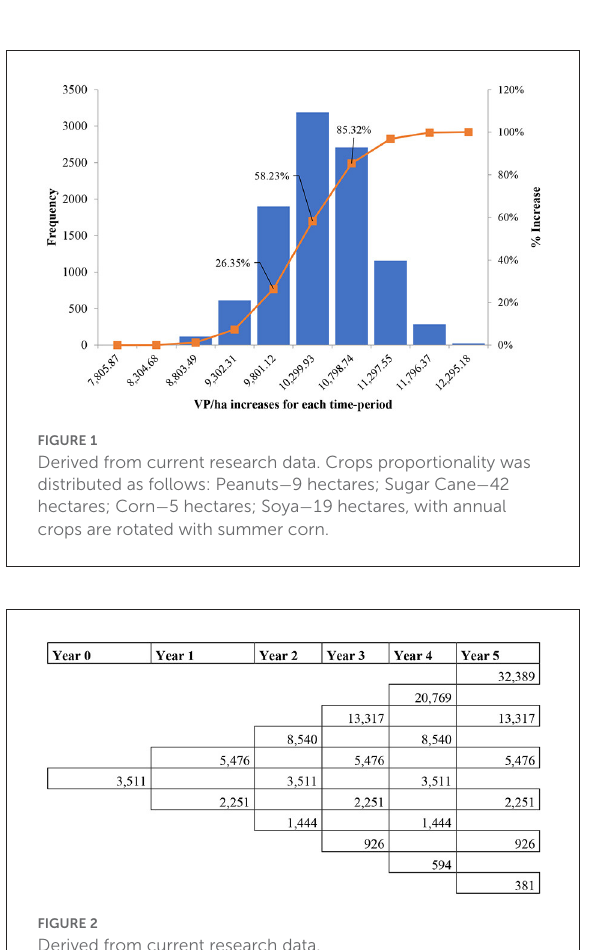
FIGURE2 Derived from current research data.